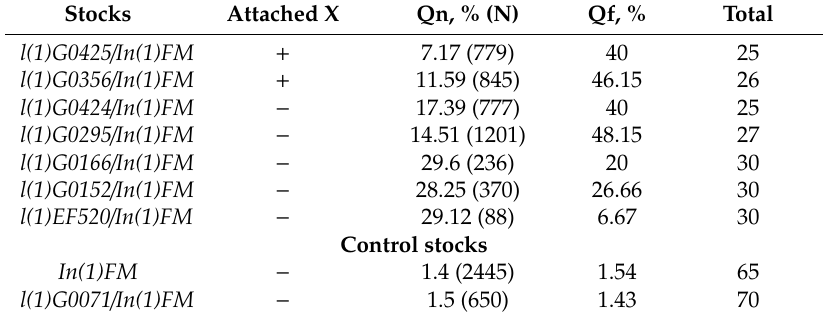
Table 1. X-chromosome nondisjunction and existence of attached-X chromosomes in females with lethal Trf2 mutations. The first column indicates Trf2 alleles balanced on In(1)FM and control stocks. The second column indicates the presence (“ + ”) or absence (“ − ”) of females with attached-X chromosomes. The third column indicates the frequency of X-chromosome nondisjunction Qn. The number (N) of analyzed flies in the progeny of females with X-chromosome nondisjunction is given in brackets. The fourth column indicates the frequency of parental females with X-chromosome nondisjunction Qf. The fifth column indicates the number of parental females analyzed. Stocks Attached X Qn, % (N) Qf, % Total